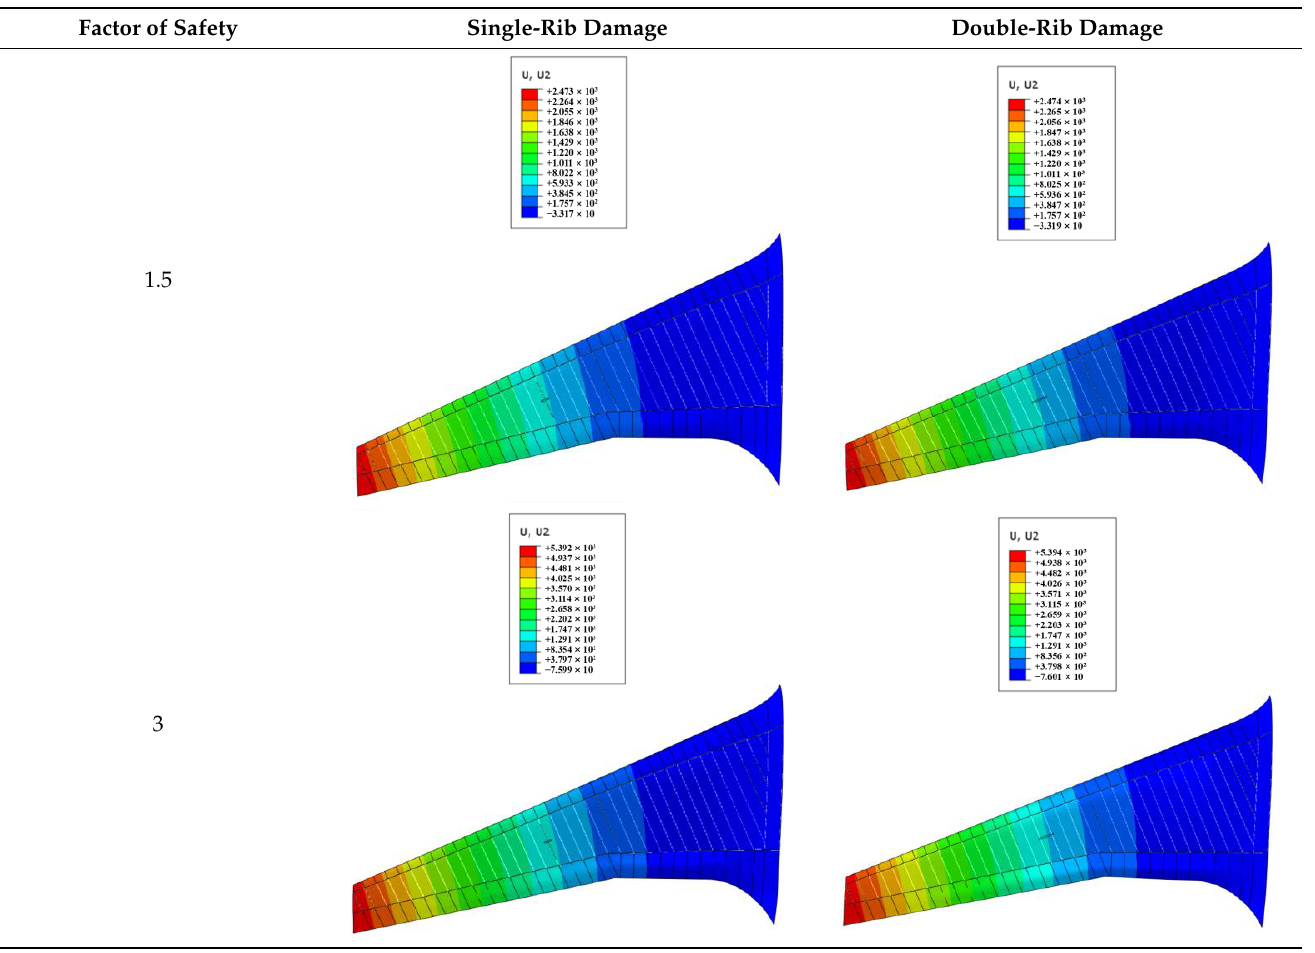
Table 14. Results of out-of-plane displacement of single-rib and double-rib damage BWB wings at different values of F.o.S.